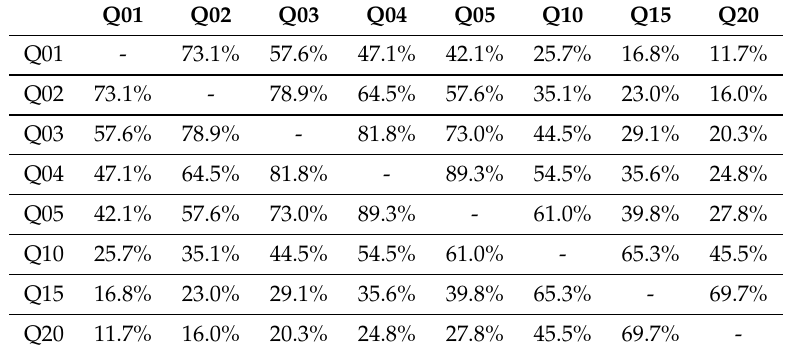
Table 10. Percentage of the larger file representing the smaller file with content in Microsoft Word